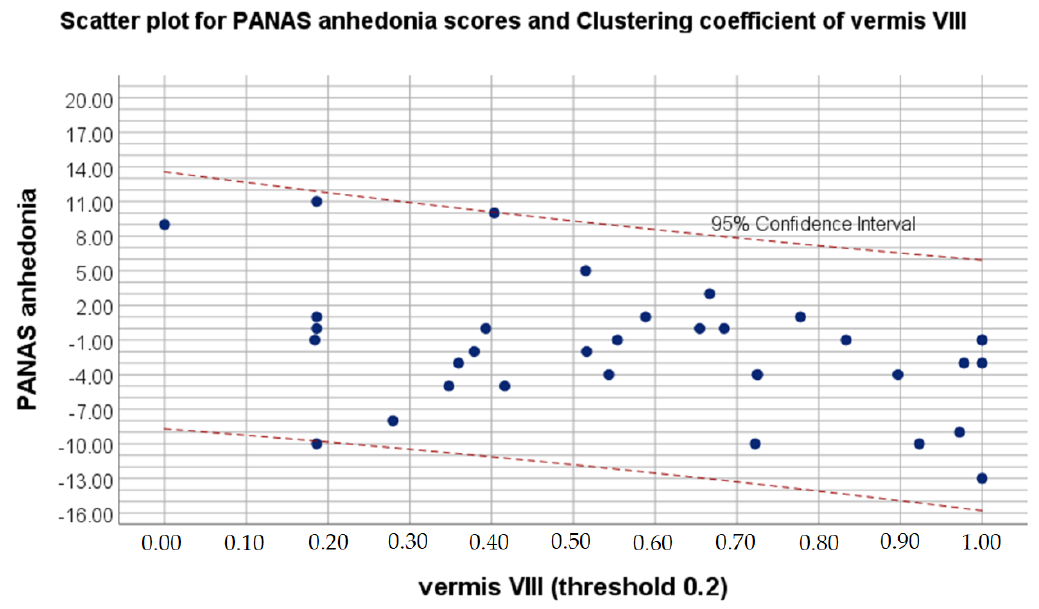
Figure 1. Scatter plot for SHAPS pleasure scores and Eigenvector centrality values on 0.35 threshold of left cerebellum VIIb.